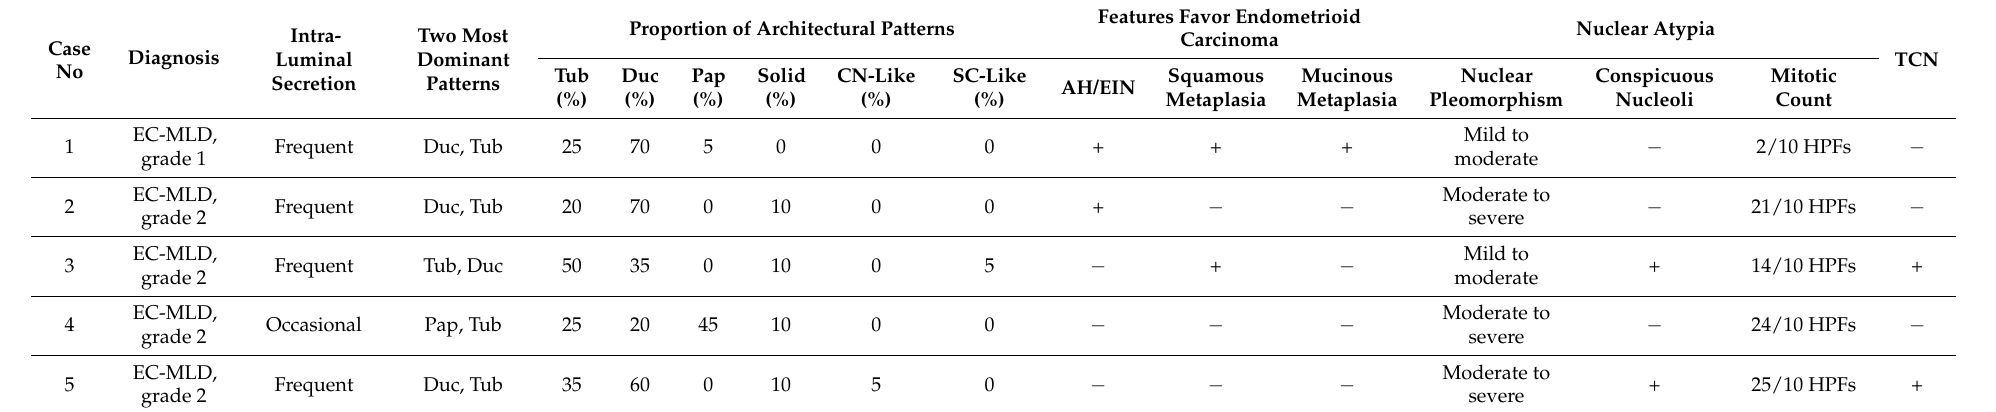
Table 3. Pathological characteristics: detailed histological